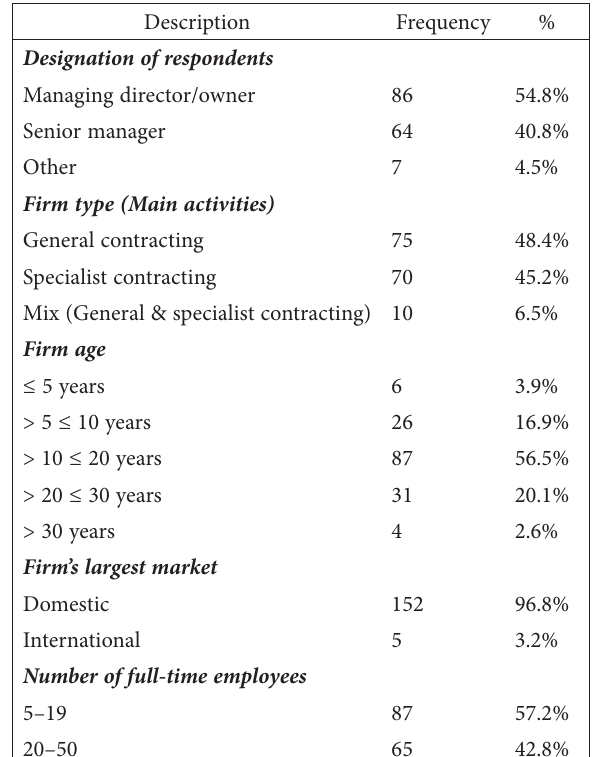
Table 3. Characteristics of respondents and their